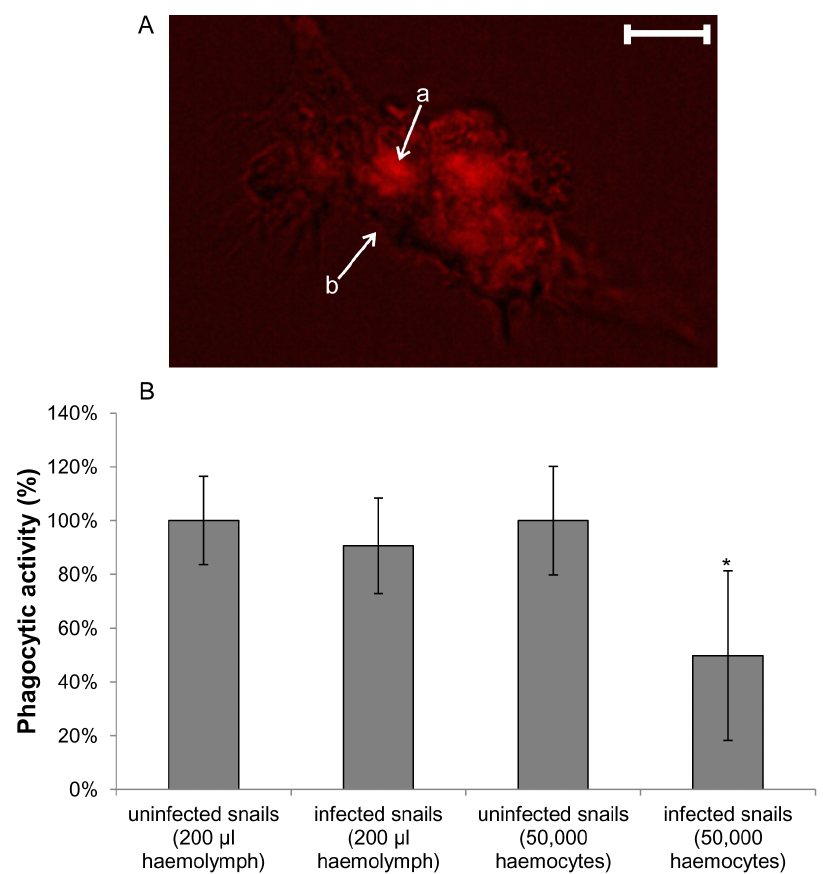
Figure 4. Phagocytosis of E.coli bioparticles by haemocytes from uninfected and Trichobilharziaregenti infected Radixlagotis . Phagocytic activities were assessed by incubating E. coli bioparticles with haemocyte monolayers and assessing the relative fluorescence of internalised particles after 2 h using a microplate reader. (A) The combined (phase-contrast and fluorescence) image of E. coli bioparticles (a) within a haemocyte (b); scale bar=10 m m. (B) Data were evaluated per volume of haemolymph (200 m l) and per number of haemocytes (50,000) (shown as mean values 6 SEM; n=7) with uninfected snails considered as having 100% activity. *p , 0.05 when compared to uninfected snails (50,000 haemocytes); Wilcoxon test.